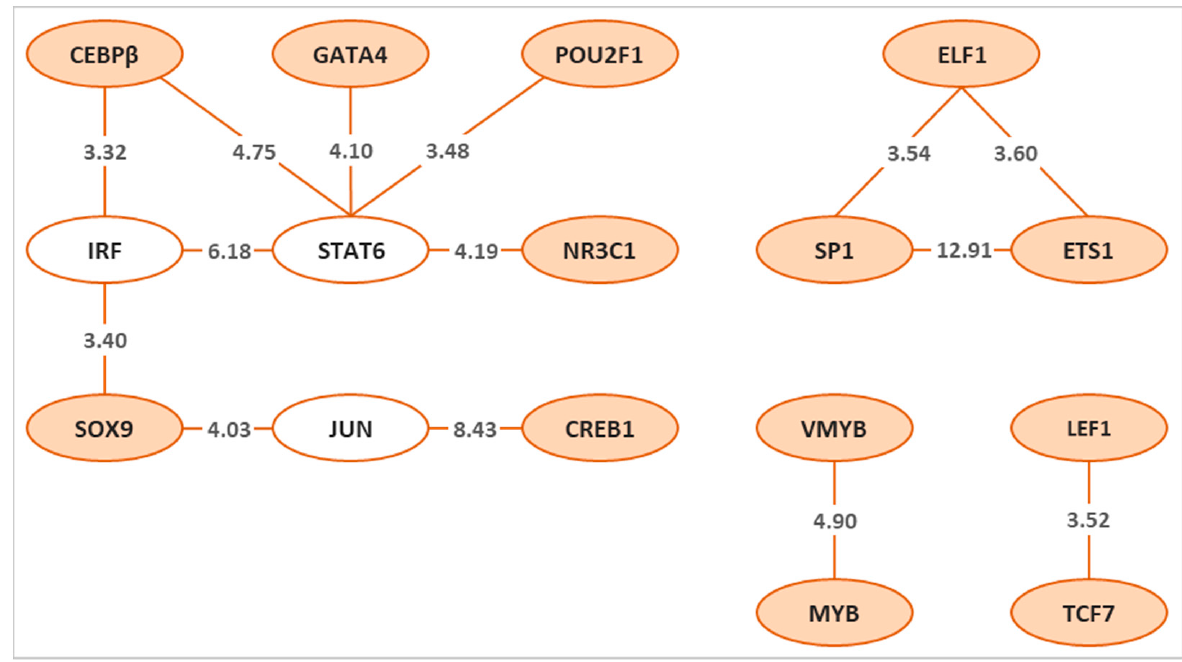
Figure 3. The significant specific transcription factor pairs for colour pattern genes in zebrafish. Nodes represent the identified transcription factors for colour in orange or white, and edges represent their potential cooperation. The top three highly connected transcription factors (hubs) in the network are shown in white. The z-score for each transcription factor pair is illustrated on the connecting line.